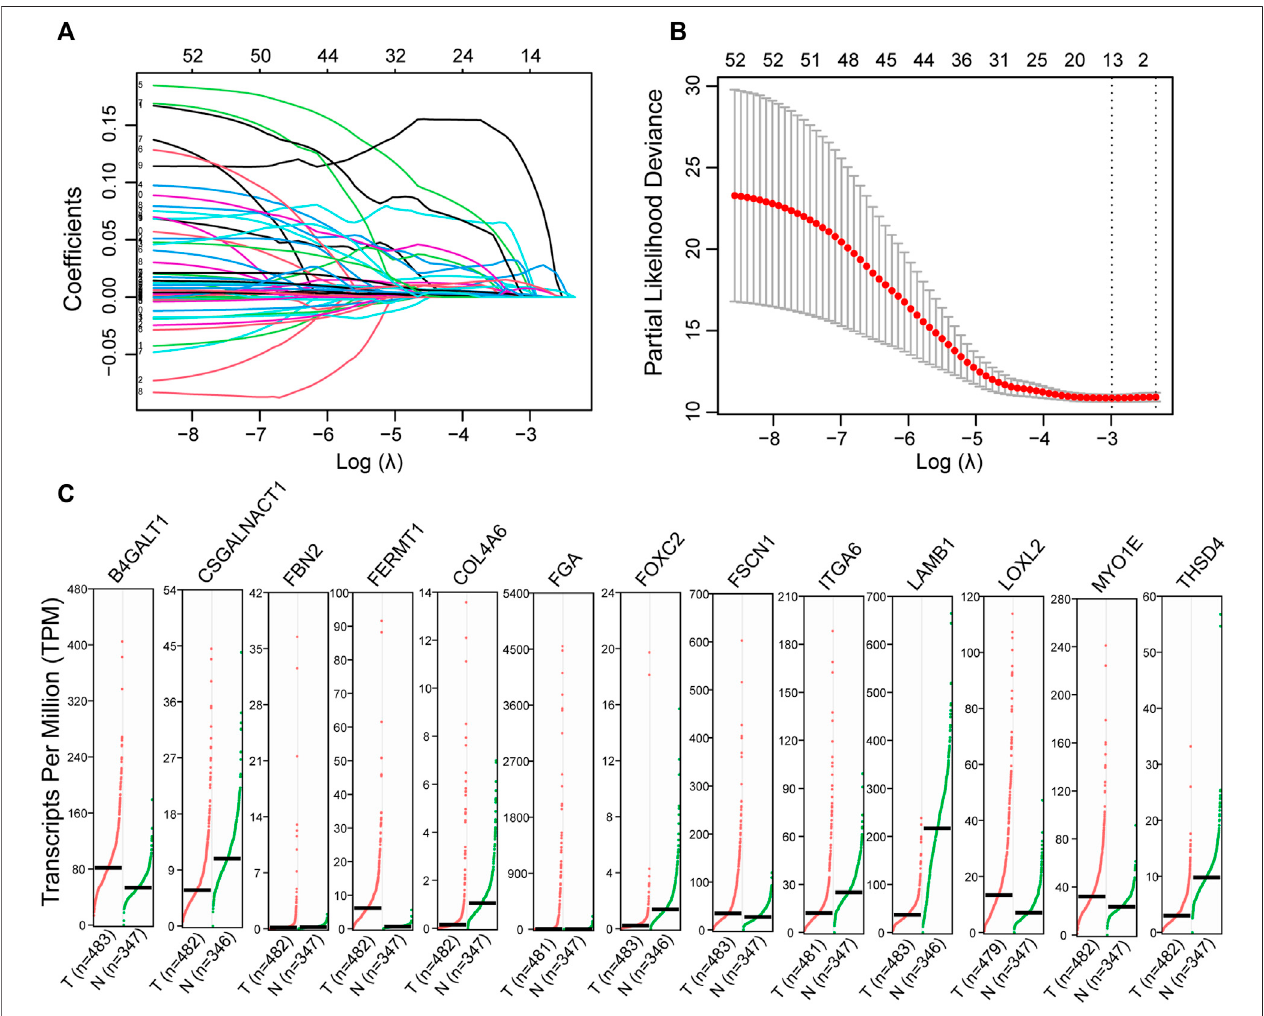
FIGURE 1 | Identi fi cation of the ECM organization-related prognostic signature. (A) The changing trajectory of every single gene identi fi ed with univariate Cox proportional hazards analysis. (B) The con fi dence interval at different value of λ . (C) The expression level of potential prognostic candidates in LUAD (GEPIA). These genes were selected by Cox regression with LASSO. Dot plots pro fi ling gene expression between LUAD (red dots) and normal adjacent lung tissues (green dots), with each dot representing a sample. The TPM value was used to display the relative expression of these genes.